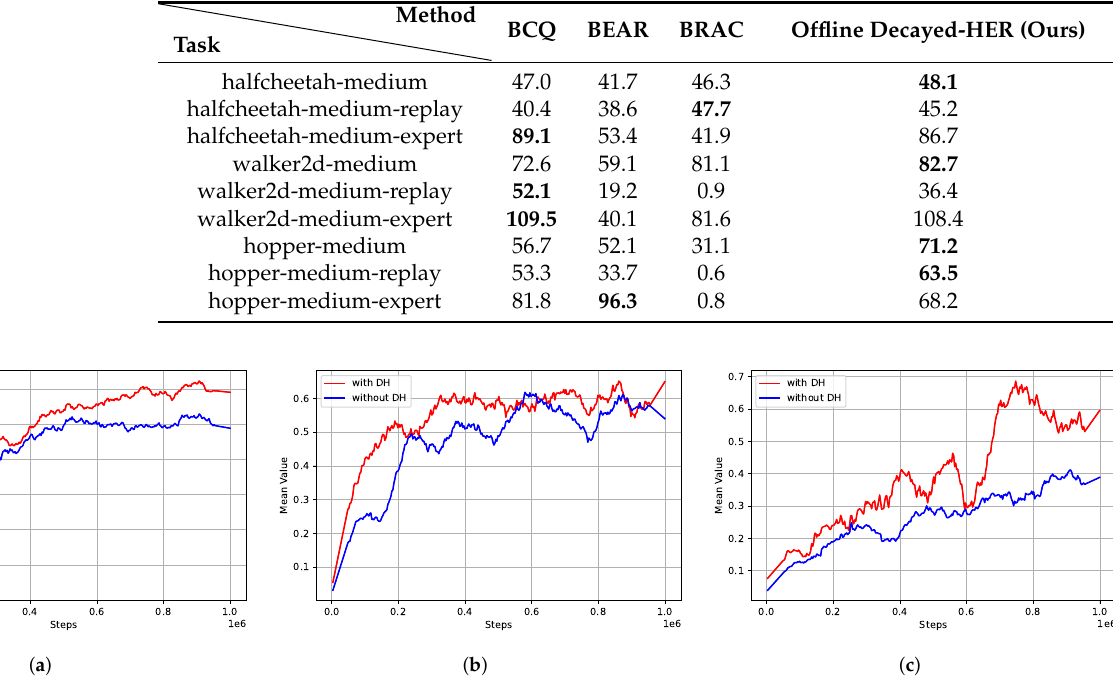
Figure 6. Ablation study on DH over datasets ( a ) medium, ( b ) medium-replay and ( c ) medium-expert. Offline goal-conditioned RL with DH performs better than